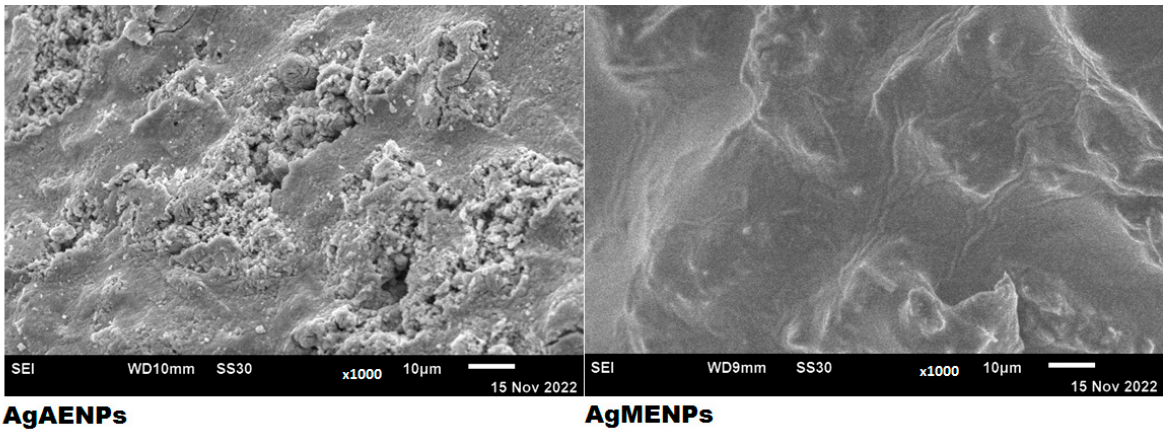
Figure 5. SEM analysis of AgAENPs and AgMENPs resulting from the green synthesis.